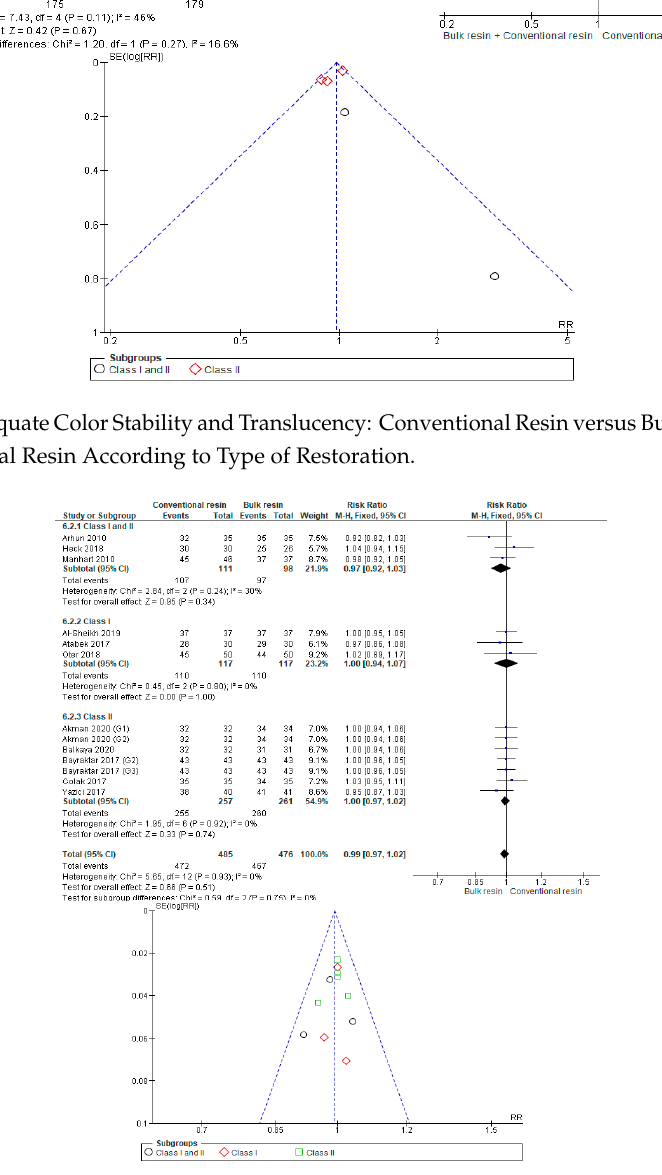
Figure A27. Adequate Color Stability and Translucency: Conventional Resin versus Bulk Resin According to Type of Restoration.